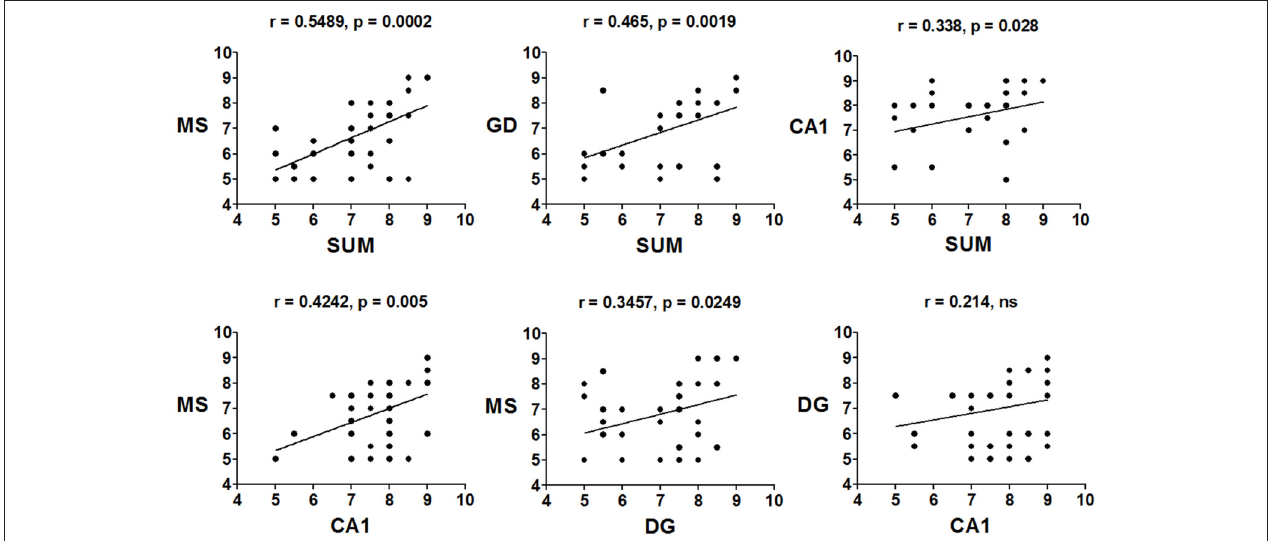
FIGURE 6 | Correlations of the mean frequency peak of the RP in the theta band (5–10Hz) between cerebral regions, across training days, in the CTR group. Significant positive correlations between the three regions (MS, SUMn and Hippocampus), but not within the hippocampus (DG and CA1) were observed (ns, no significant).